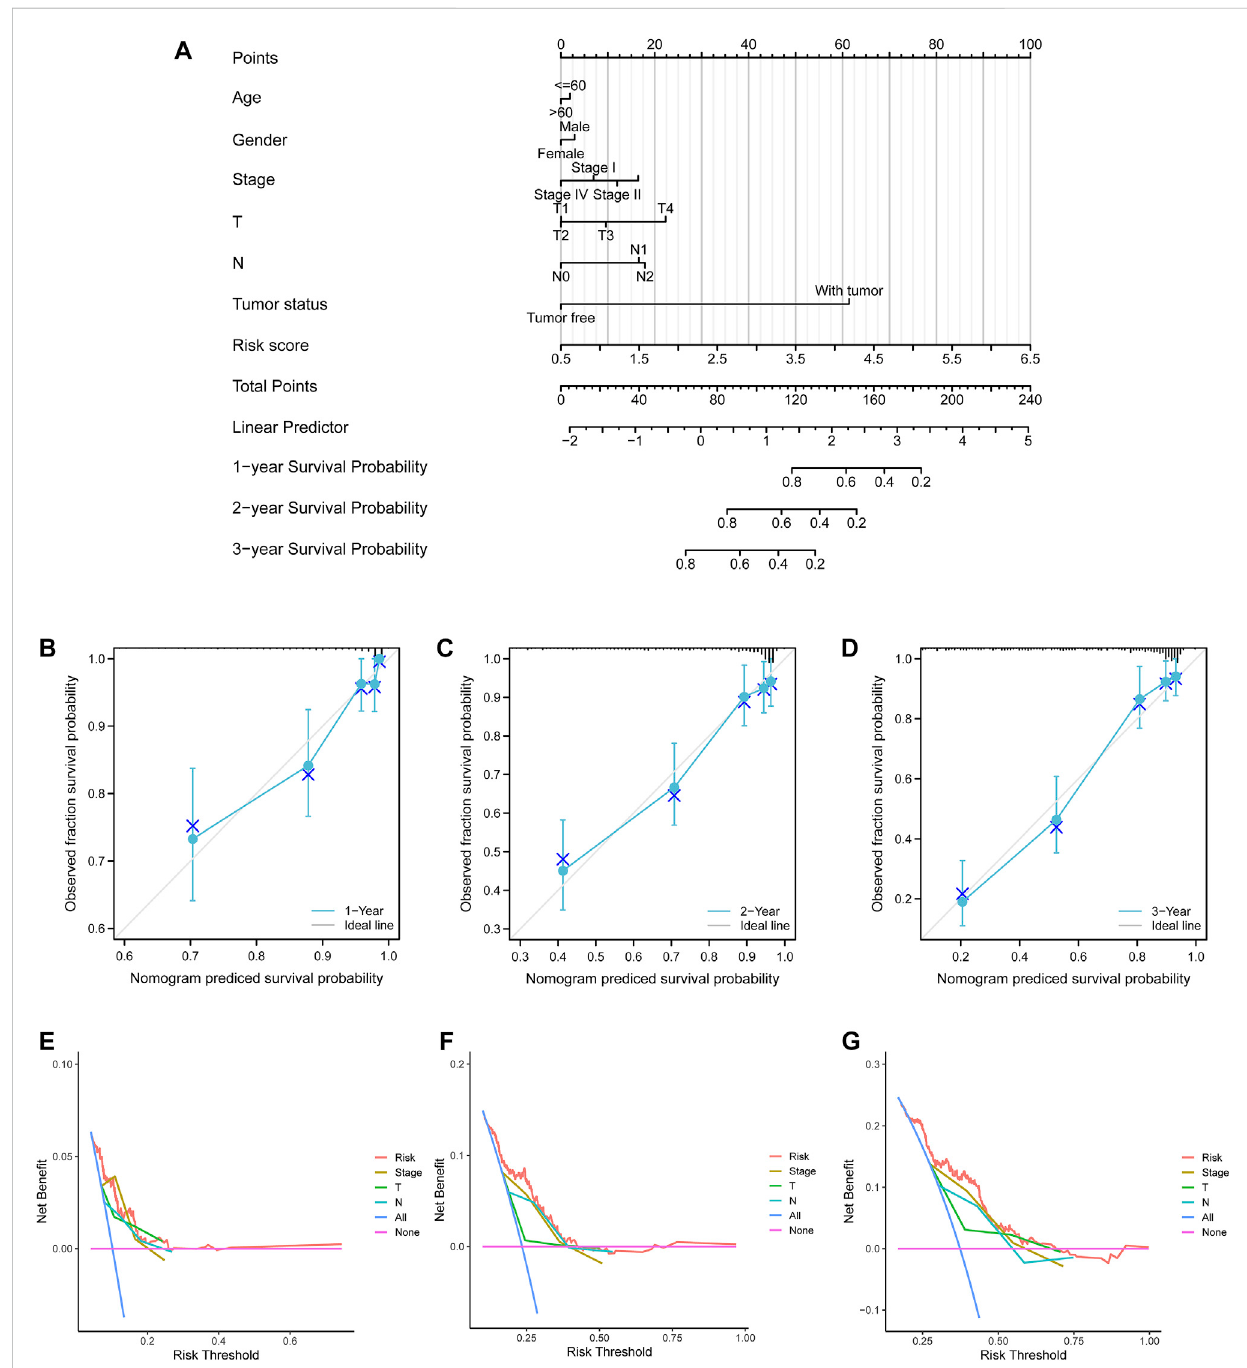
FIGURE 7 Nomogram model and decision curve analysis curves. (A) A nomogram model to predict lung adenocarcinoma patients ’ survival with clinicopathological variables and risk scores. (B – D) 1-, 2-, and 3-year calibration curves. Blue crosses represented the result of each point after the strati fi ed Kaplan – Meier correction. Small gray vertical lines at the top of the boxes represented the distribution of survival rates under the model predictions. (E – G) 1-, 2-, and 3-year survival probability decision curve analysis curves for the pathological stage, T stage, N stage, and risk